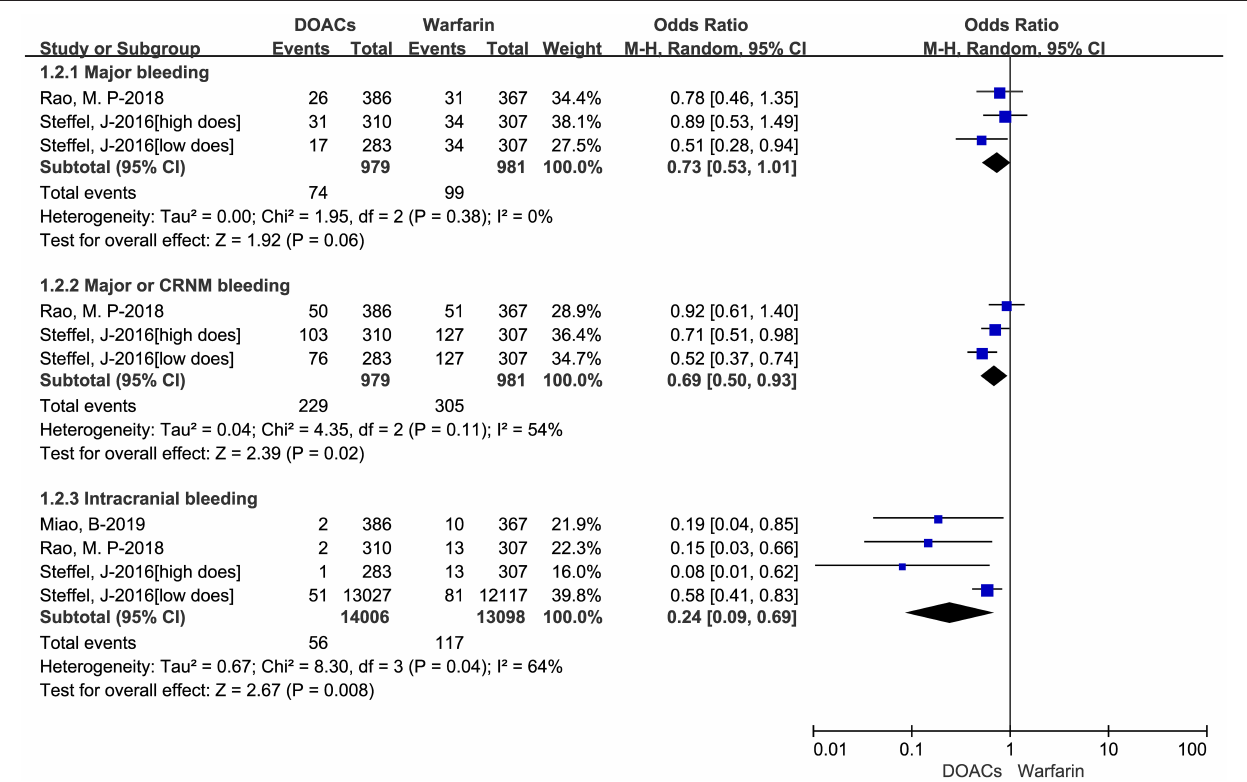
FIGURE 2 | Crude safety event rates of direct oral anticoagulants compared with warfarin among atrial fibrillation patients at risk of falling. DOACs, direct oral anticoagulants; CRNM, clinically relevant nonmajor bleeding.